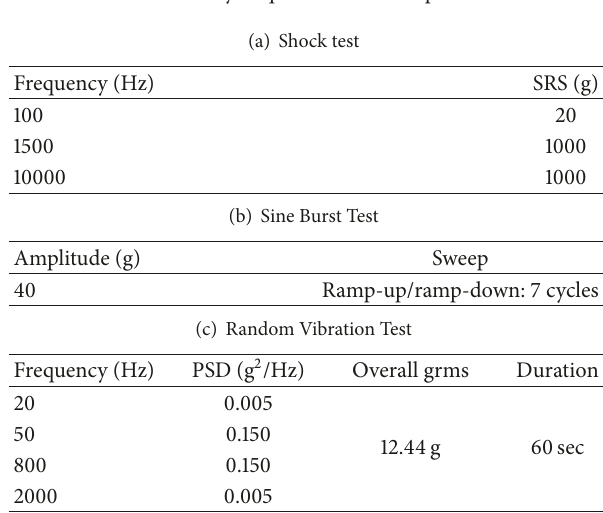
Table 3: Summary of qualification test